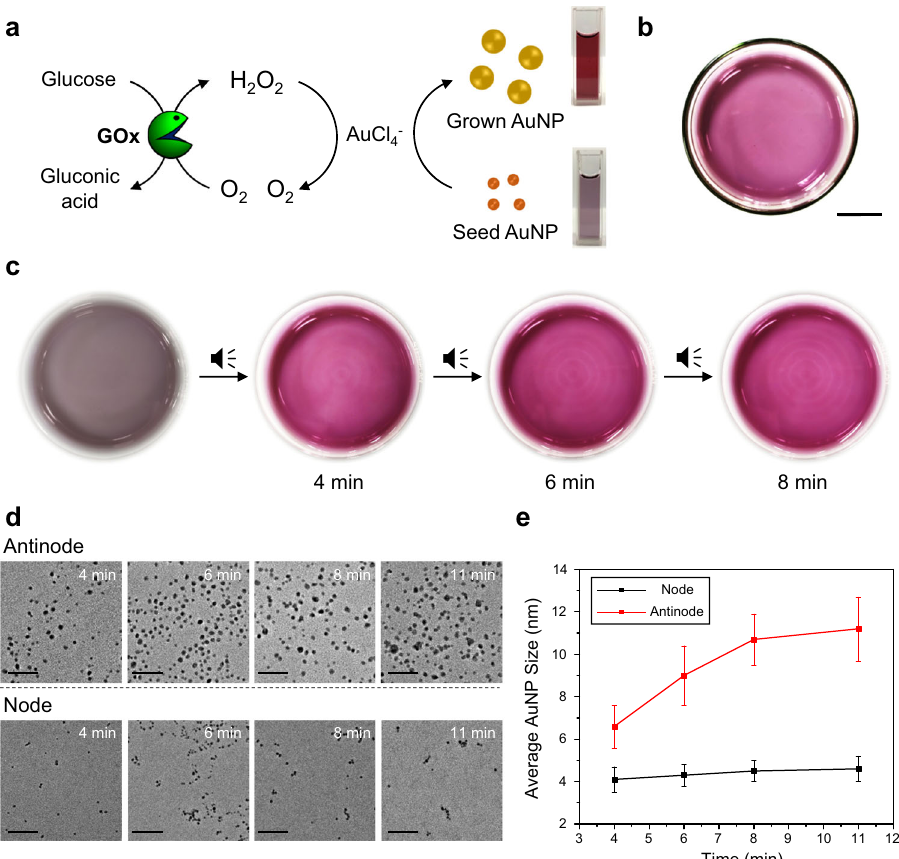
Fig. 3 Audible sound mediated spatiotemporal control over glucose/GOx/AuCl 4 - /seed AuNP cascade reaction. a Schematic representation of glucose/ GOx/AuCl 4 - /seed AuNP cascade reaction. Here the colored pattern is generated from the in suit grown AuNPs. GOx: glucose oxidase, AuNP: gold nanoparticle. b Pattern generated without applying audible sound (scale bar is 1.5 cm). c Time-dependent changes of circular pattern generation with applying 30 Hz of audible sound. d TEM images of AuNP solutions taken at the antinodal (top) and nodal (bottom) positions of the colored pattern at 4, 6, 8, and 11 min, respectively (scale bar is 50 nm). e Plots for the time-dependent changes in the average size with standard deviation ( N = 100) of the nanoparticles obtained from the TEM images from samples at the antinodal and nodal positions of the solution,